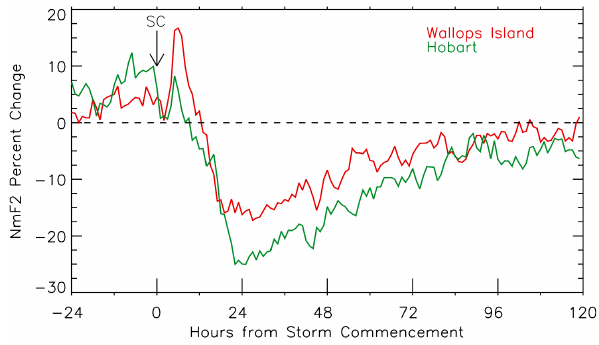
Fig. 5. A comparison of the average patterns from Figs. 3 and 4. Note that the pre-storm pattern does not span zero, a feature seen in all such analyses since Matsushita (1959) that arises from the monthly mean containing so many negative phase days.